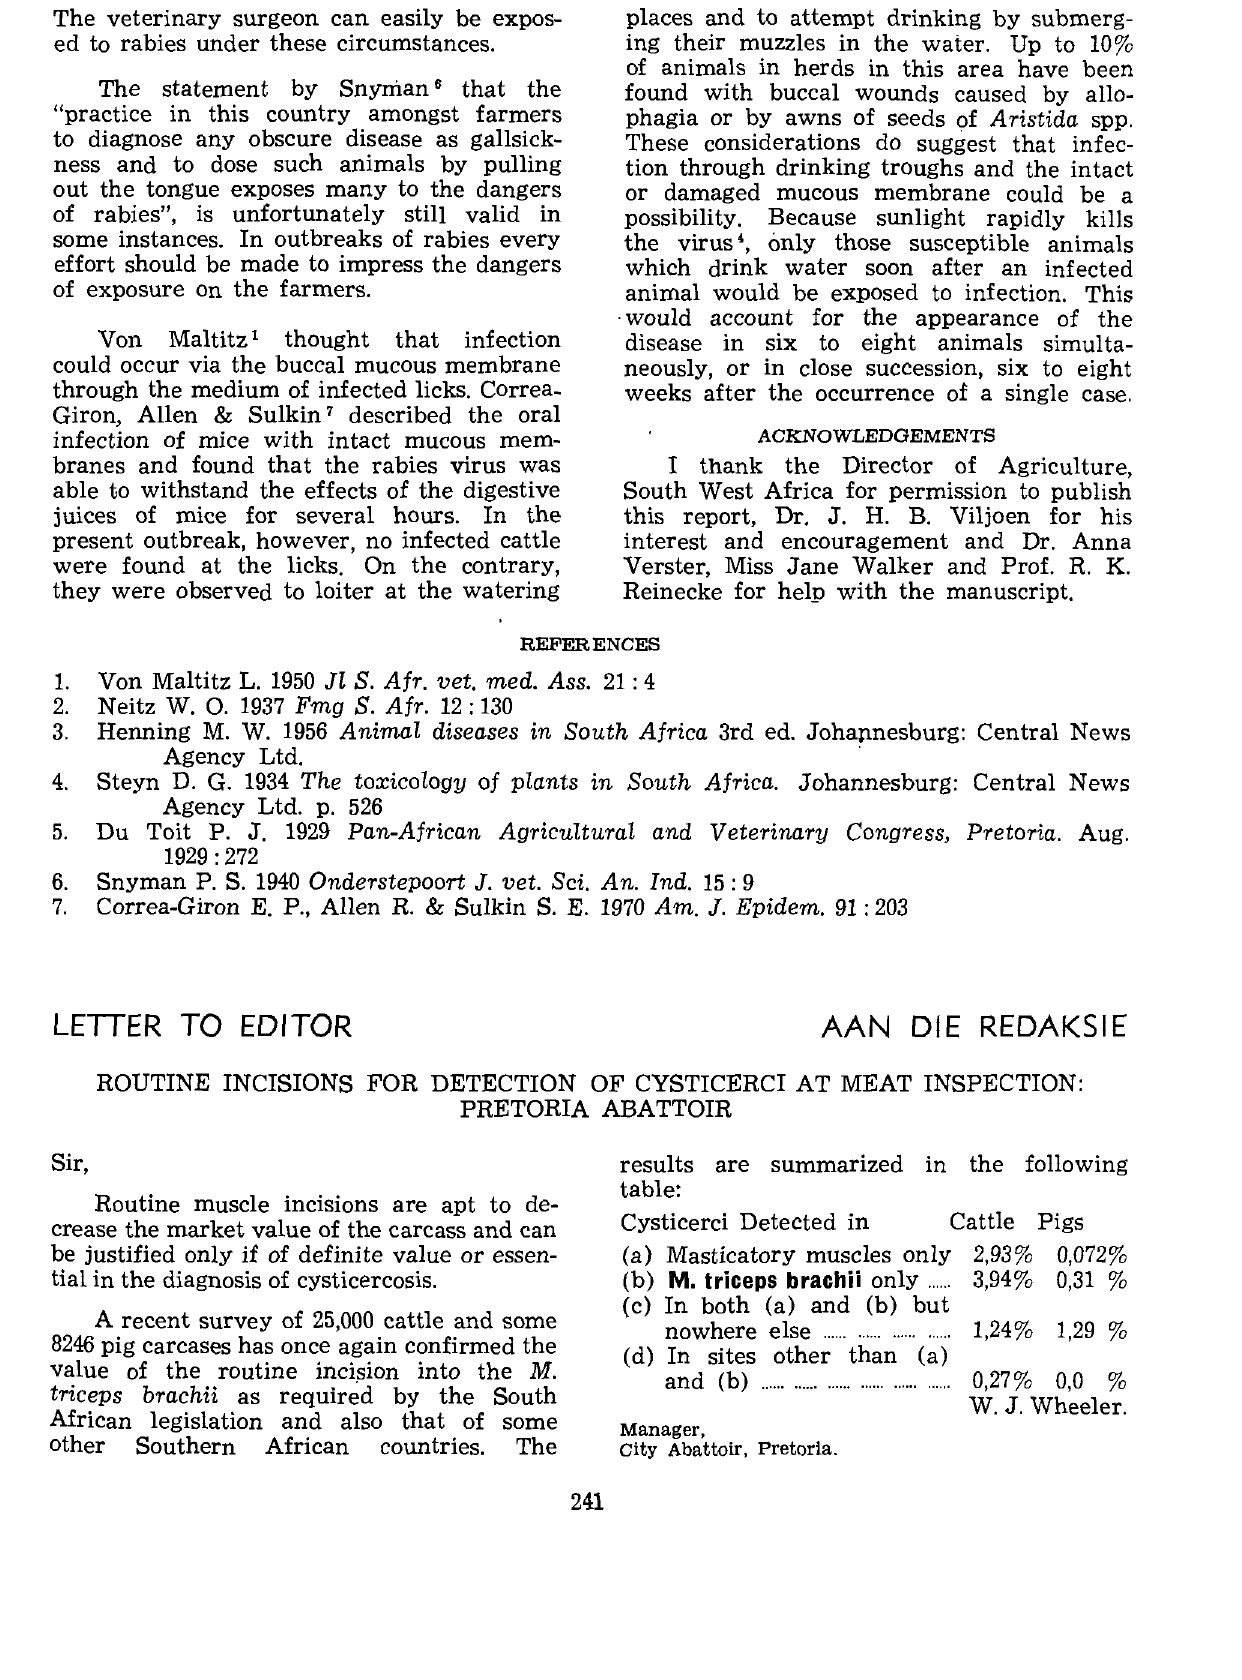
Cysticerci Detected in Cattle